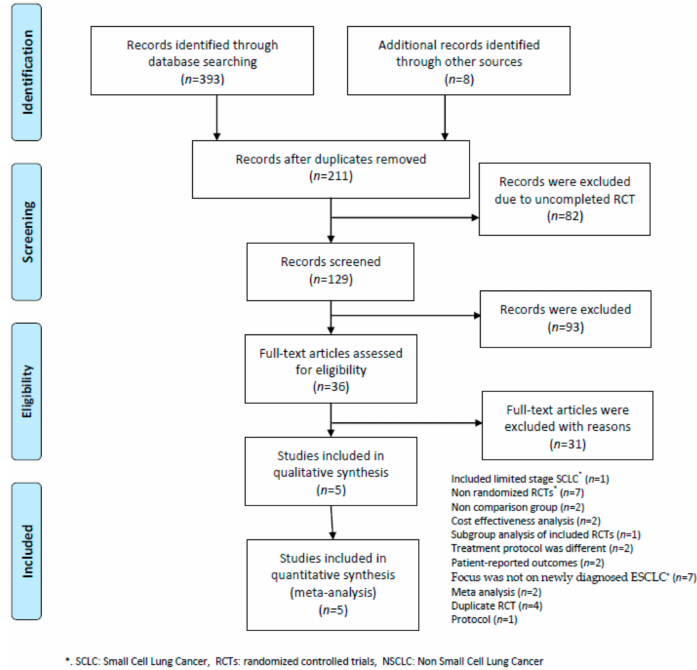
Figure 1. PRIMSA flow